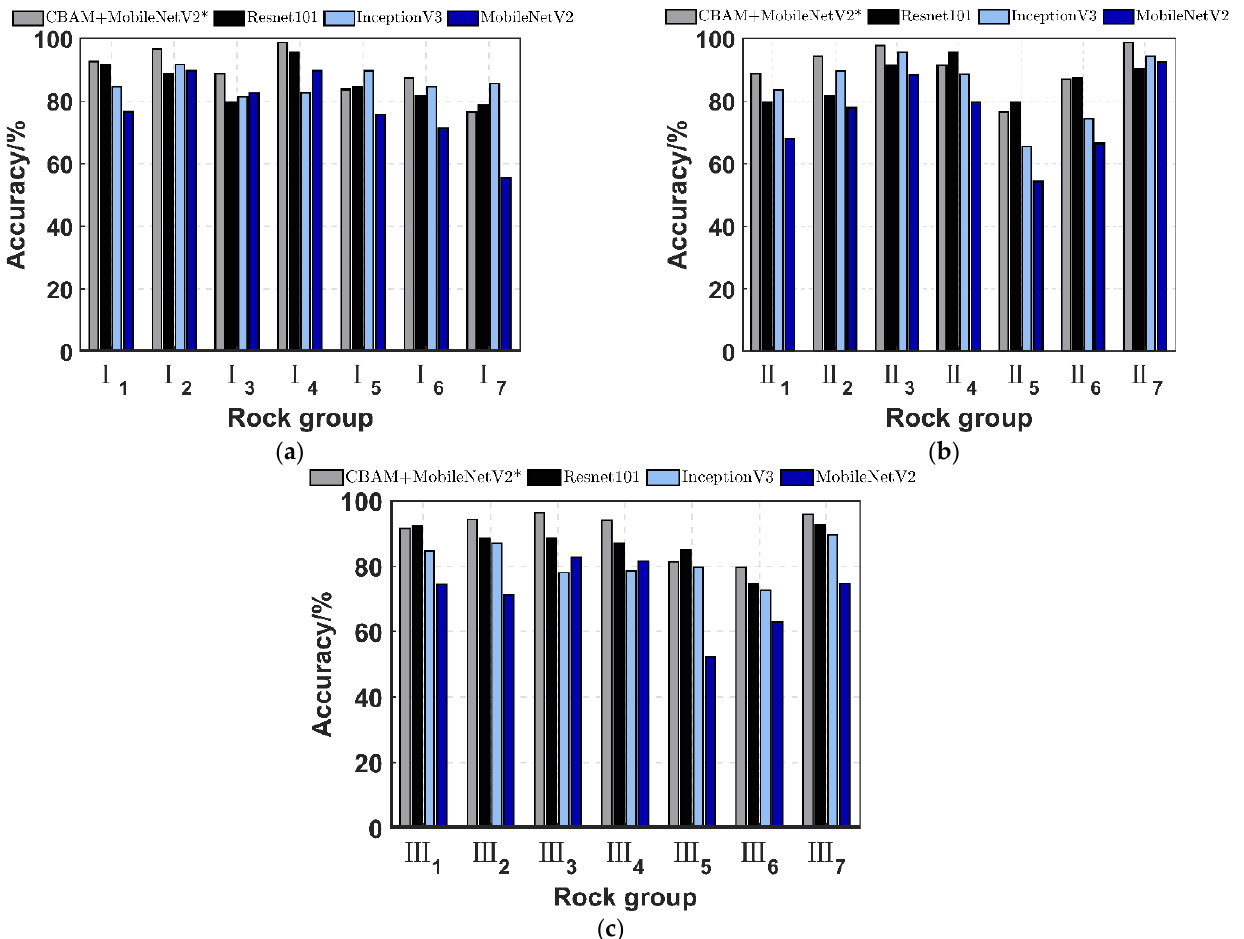
Figure 8. Comparison of correct classification rate of rock images. ( a ) Comparison of the accuracy of Class I lithology recognition; ( b ) Comparison of the accuracy of Class II lithology recognition; ( c ) Comparison of the accuracy of Class III lithology recognition.